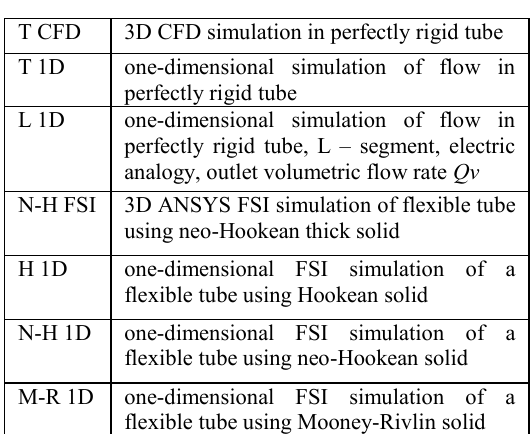
Fig. 4. Pressure boundary condition. Table 3. Markings used in legend.